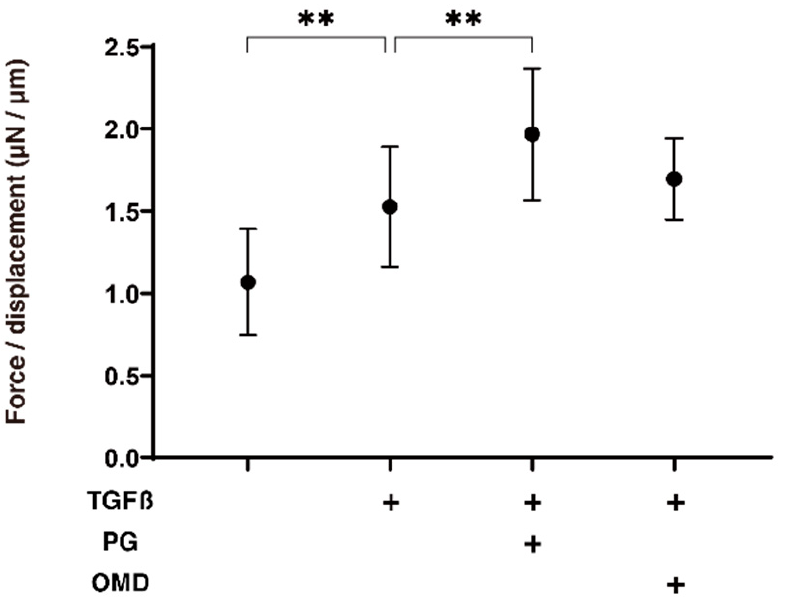
Figure 3. Effects of PGF2 α and the EP2 agonist, omidenepag (OMD), on stiffness of TGF β 2-treated 3D HTM spheroids.To compare the effects of 100 nM PGF2 α (PG) and omidenepag (OMD) on the stiffness of the 5 ng/mL TGF- β 2 (TGF β ) HTM 3D spheroids, those at day 6 were subjected to a micro- squeezer analysis in addition to TGF β untreated controls. The required force ( μ N) was measured and force/displacement ( μ N/ μ m) were plotted ( n = 10–12 3D spheroids in each experimental condition). “+” is reagents addition. Data presented are the arithmetic mean ± standard error of the mean (SEM), and statistical differences were determined by ANOVA followed by a Tukey’s multiple comparison test. ** p < 0.01. To elucidate the underlying mechanisms responsible for the above effects by PGF2 α and OMD on the TGF- β 2-treated 2D- and 3D-cultured HTM cells, the expression of ECM proteins ( COL1, 4 , and 6, FN , and α SMA ) was estimated by qPCR analysis and immunolabeling. The administration of TGF- β 2 induced a significant up-regulation in the mRNA expressions of all ECMs molecules (2D), and COL1, COL6 , and FN (3D). The addition of PGF2 α or OMD induced a significant up-regulation in COL4 (2D) and a down- regulation in COL1 (3D), COL6 (3D), FN (3D), and α SMA (3D), and a substantial up- regulation of COL4 (2D) and down-regulation of COL6 (3D) and FN (3D), respectively (Figure 4). Immunolabeling of 2D-cultured HTM cells with specific antibodies was nearly identical to those for gene expression (Supplemental Figure S1). However, in contrast, the